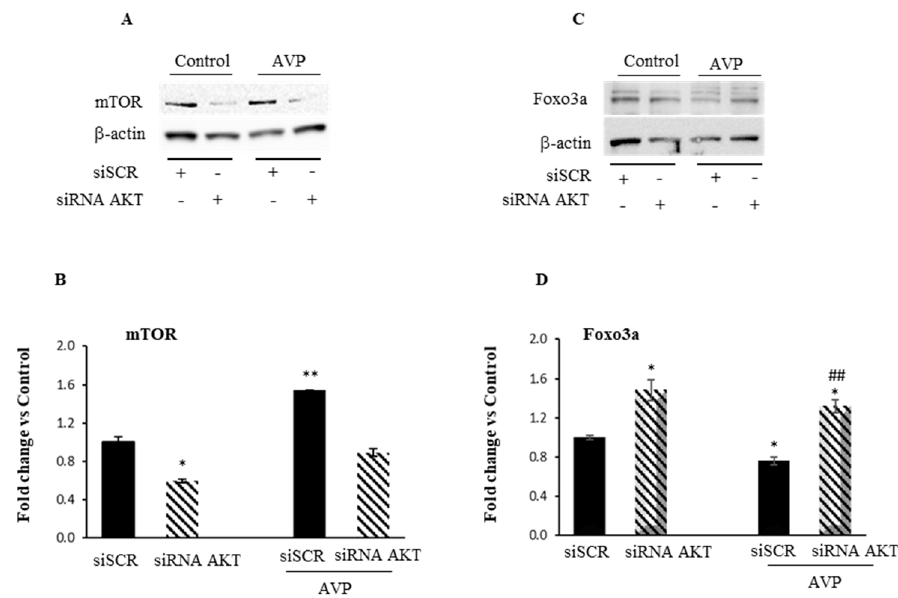
Figure 3. Akt knockdown hampered the myogenic effect of AVP in L6 cells. ( A , C ) Representative Western blots showing respectively mTOR and FoxO protein expression in L6 cells after silencing of AKT1. ( B , D ) Densitometric analyses were achieved using an anti- β -actin antibody to verify the equal loading of the samples. Statistical analysis was performed using Student’s t -test. * , p < 0.05; ** ,## p < 0.01; * vs. Control; # vs. AVP.